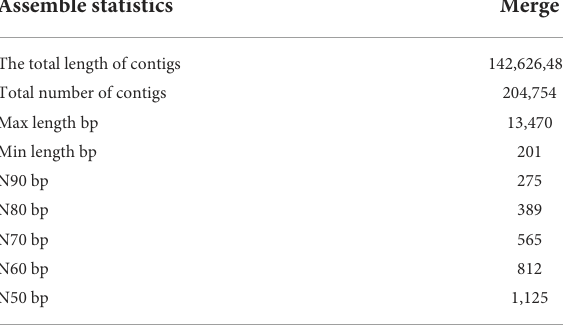
TABLE 1 Summary of de novo transcriptome